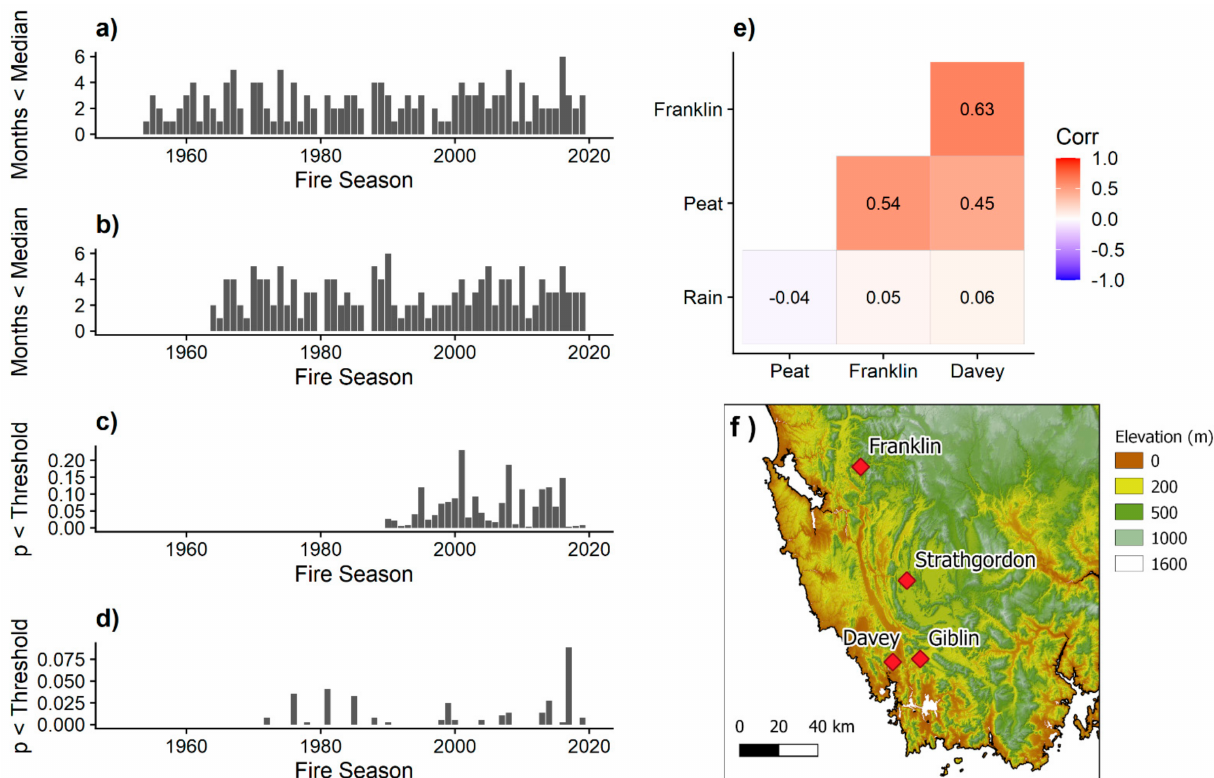
Figure 8. Number of months per fire season (July to June) below the median flow threshold for the ( a ) Franklin and ( b ) Davey rivers; ( c ) the proportion of the fire season with soil moisture content below the 17% threshold at the location of the Giblin River fire based on [18], and ( d ) the proportion of the fire season where the previous 30 days had <50 mm of precipitation at Strathgordon based on [17]. Panel ( e ) shows Pearson correlation coefficients between the seasonal indices shown in panels ( a – d ) for coinciding years of data availability. Map ( f ) shows the location of the sample points the data was taken for on a map of elevation for the